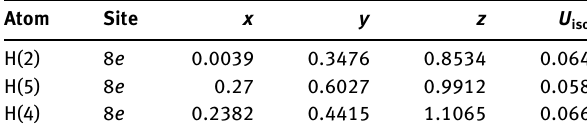
Table 2: Fractional atomic coordinates and isotropic or equivalent isotropic displacement parameters (Å 2